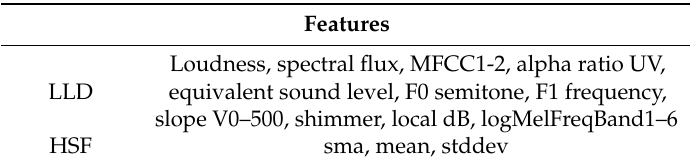
Table 1. Set of low-level descriptor (LLD)